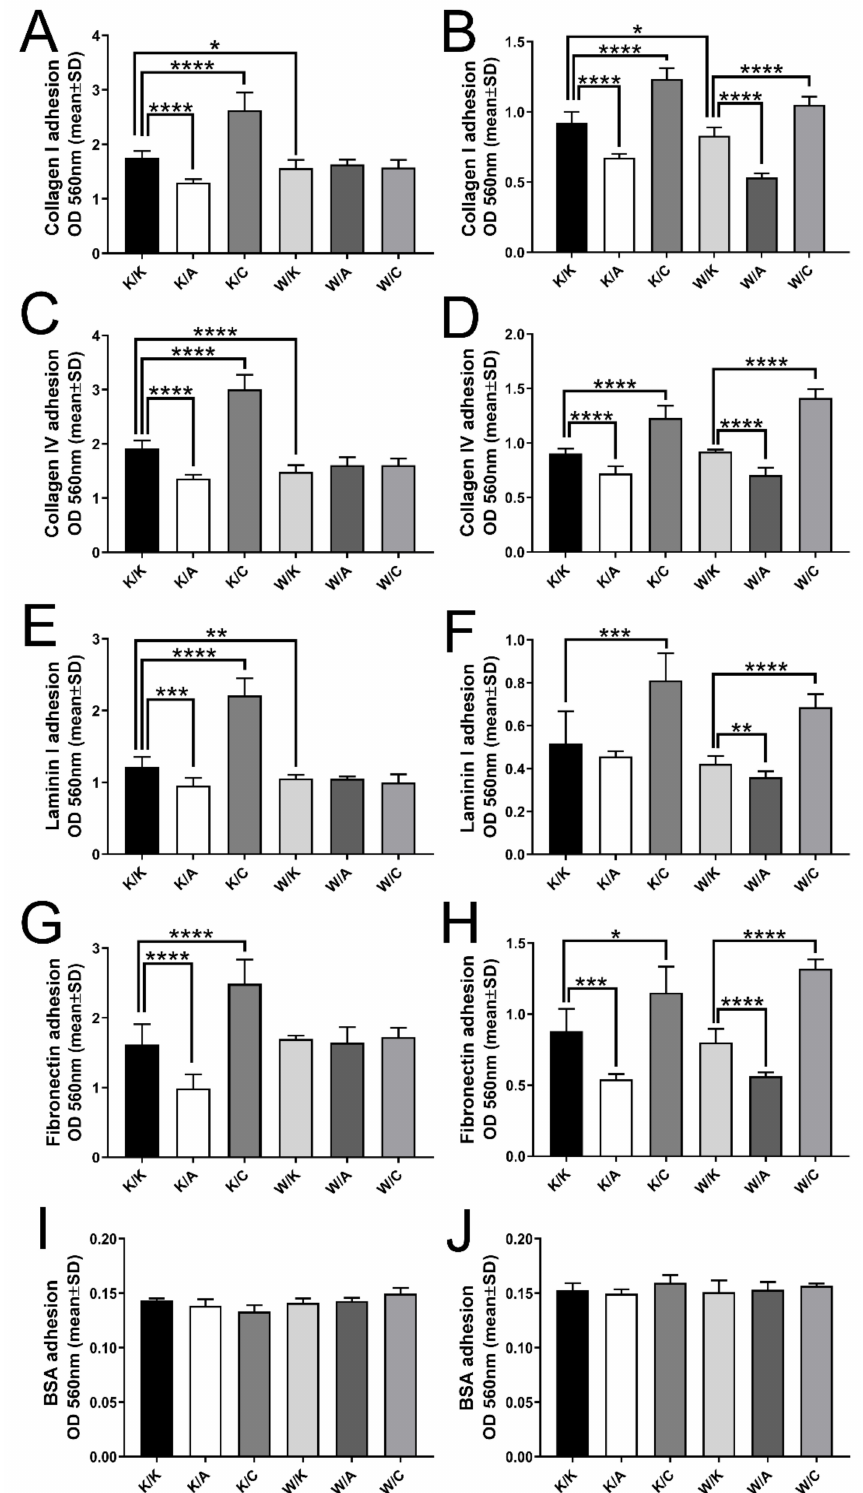
Figure 6. Variability of adhesiveness to ECM proteins. ( A , B ) Collagen I. ( C , D ) Collagen IV. ( E , F ) Laminin I. ( G , H ) Fibronectin. ( I , J ) BSA (negative control). The results are shown in pairs, i.e., A–B, C–D, E–F, etc.; the paired graphs present data of HT-1376 and CAL-29 cells, respectively. p < 0.05 (*), p < 0.01 (**), p < 0.001 (***), p < 0.0001